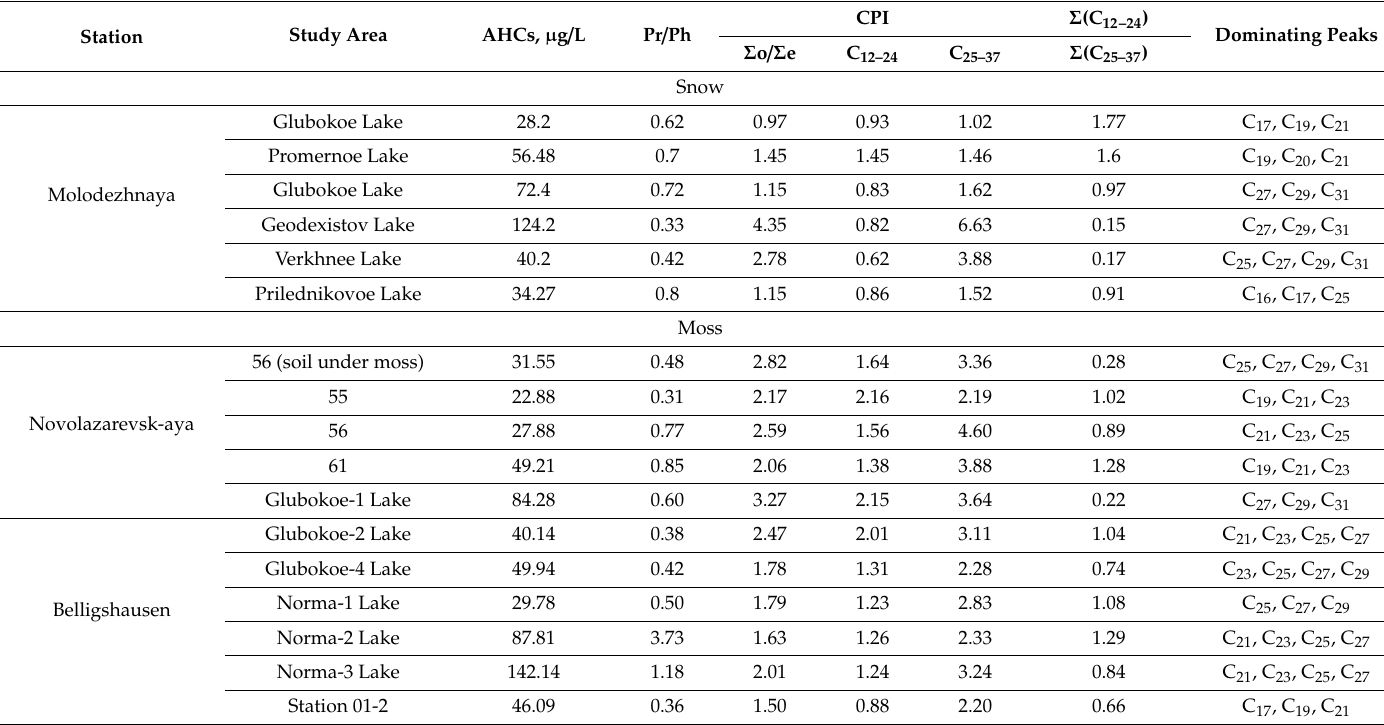
Table 4. The parameters of alkanes in SPM in snow and moss in di ff erent regions of the Antarctic.